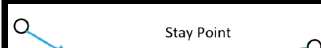
Figure 5. The extended Douglas–Peucker algorithm taking distance and time for simplification and segmentation of trajectories.